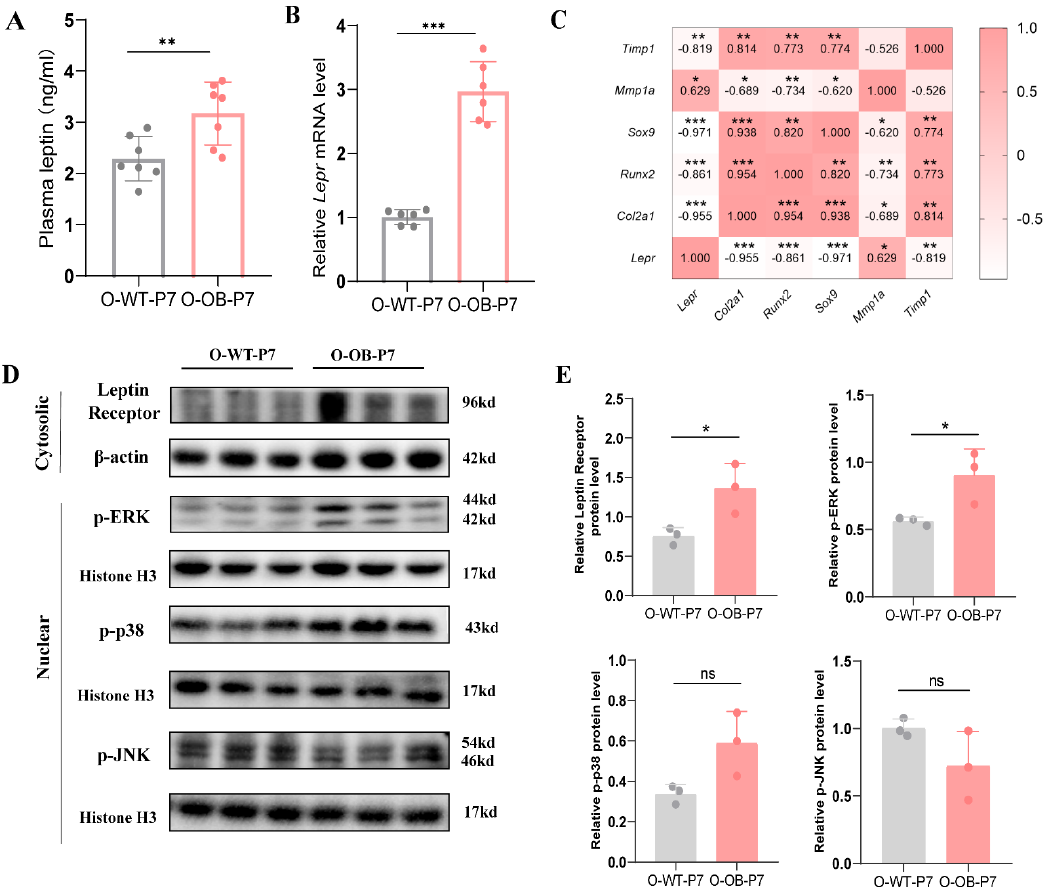
Figure 4. Leptin signaling pathway (MAPK/ERK) was activated in the knee cartilage of 7 ‐ day male mice from the maternal obesity group. ( A ) Plasma leptin level and ( B ) Lepr mRNA level of knee cartilage 7 ‐ day male mice offspring in control versus obesity groups. ( C ) Correlation between Lepr and cartilage key indicators mRNA expression levels. ( D ) Representative western blot bands of the expression of leptin receptor in the cell cytoplasm and phosphorylated ERK (p ‐ ERK), phosphorylated p38 (p ‐ 38), and phosphorylated c ‐ Jun N ‐ terminal kinase (p ‐ JNK) in the nucleus from knee cartilage of the offspring. ( E ) Statistical results of the expression of key proteins of MAPK signaling pathway in knee cartilage of the offspring. ( A ) n = 7, ( B ) n = 6, ( C ) n = 6, and ( D ) n = 6; each band represents the expression of cartilage tissue proteins in two mice. All mice in each group from at least three litters of different mothers. O ‐ WT ‐ P7: offspring 7 ‐ day male mice from the control mothers. O ‐ OB ‐ P7: offspring 7 ‐ day male mice from obese mothers. Results are expressed as mean ± SD. ns not significant, * p < 0.05, ** p < 0.01, and *** p < 0.001.